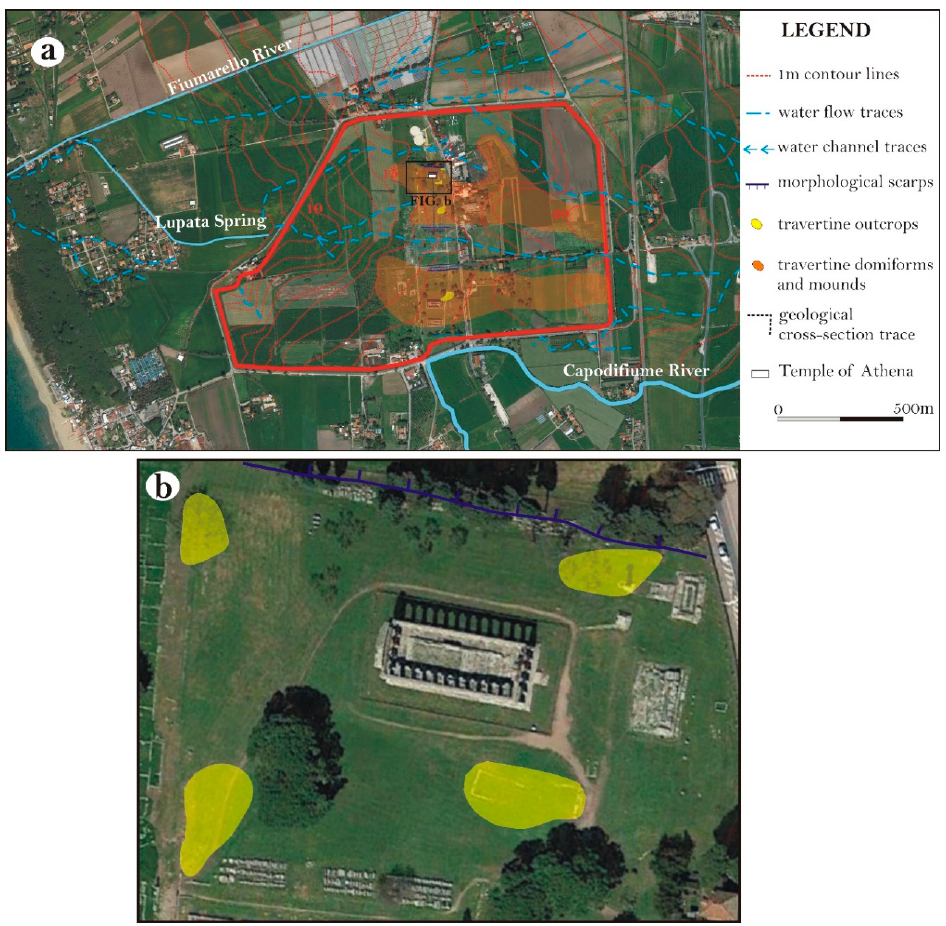
Figure 7. Geomorphological map of the Paestum archaeological area with 1 m contour lines ( a ), showing the main landforms, superimposed on a Google Earth TM satellite image, and travertine outcrops map close the Athena temple ( b